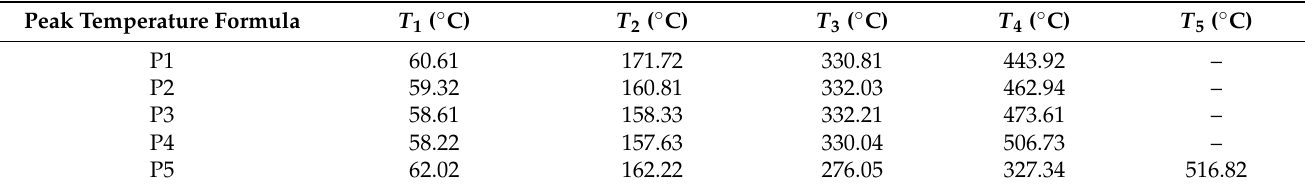
Table 4. Characteristic peak temperatures of samples P1–P5 corresponding to the DSC curve at β = 10 ◦ C · min − 1 .